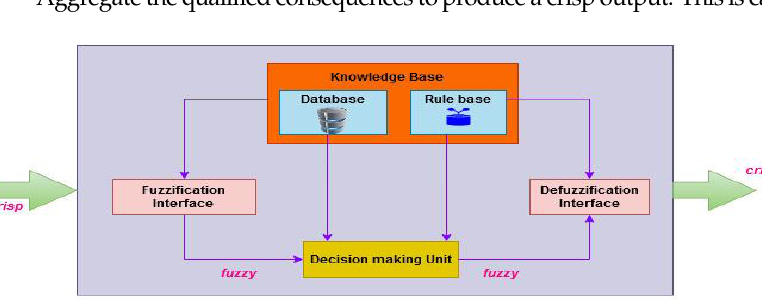
Figure 1. Functional blocks of FIS.